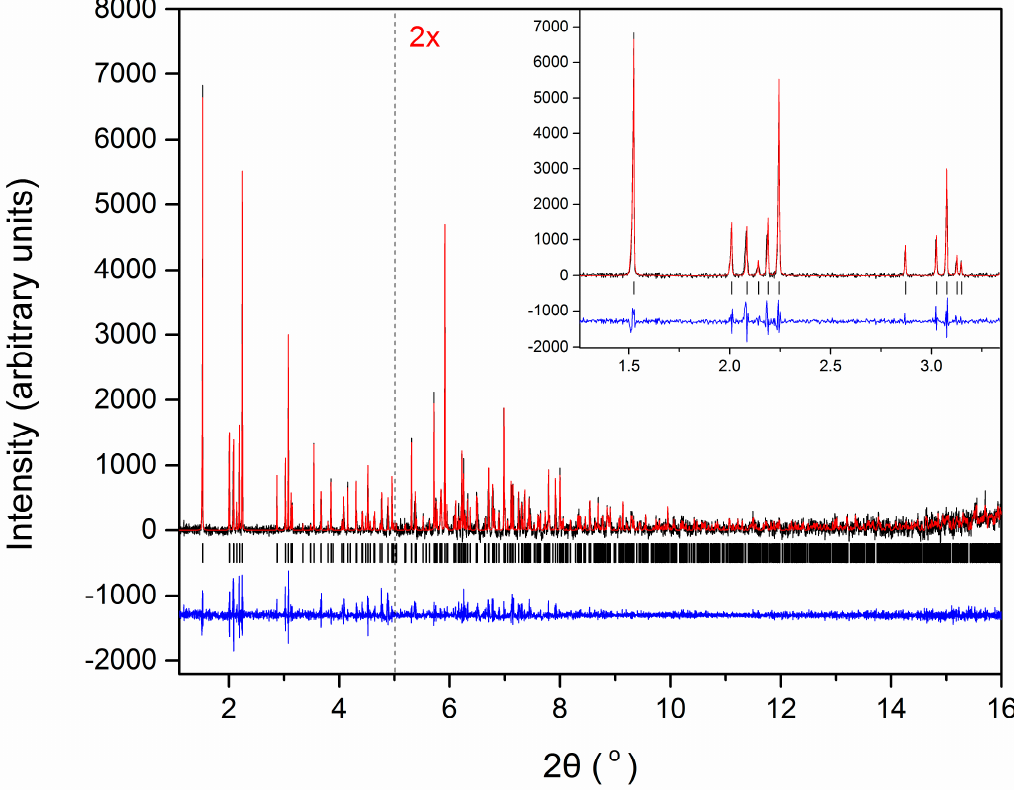
Figure 3. Pawley fit of the synchrotron XRPD profile of CVB3 3C pro (pH 8.00; space group C 2, a = 78.073 (1) Å, b = 65.577 (6) Å, c = 40.497 (1) Å, β = 115.415 (1)°, R wp = 12.745% and χ 2 = 1.651). Data were collected on ID22-ESRF (RT, λ = 1.30008 (5) Å). The black, red and blue lines represent the experimental data, the calculated pattern and the difference between the experimental and calculated profiles, respectively. The vertical bars correspond to Bragg reflections compatible with space group C 2 [71].